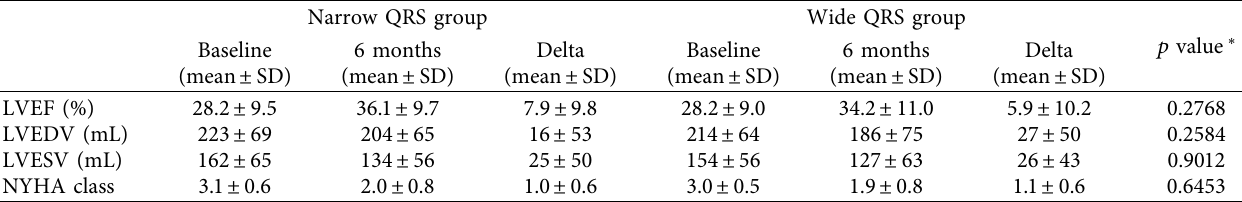
Table 2: Echocardiographic data and NYHA functional class at baseline and 6 months after CRT implantation.